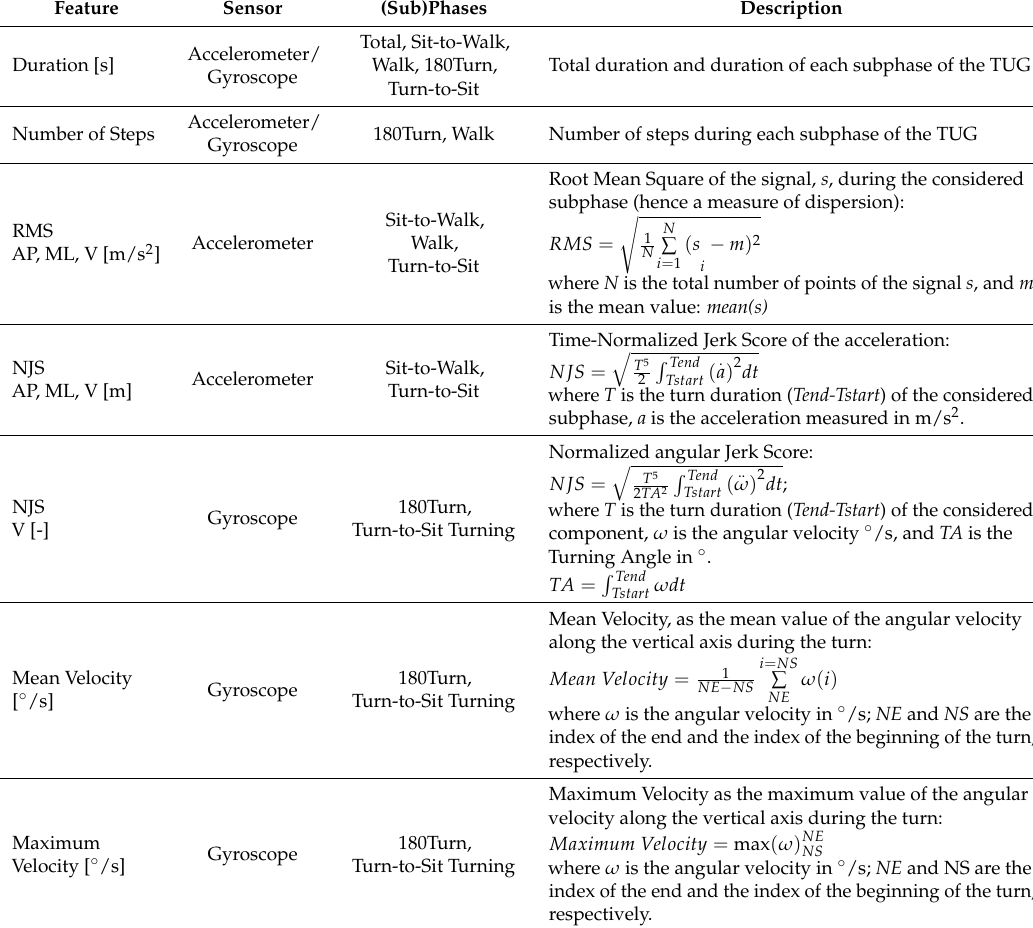
Table 2. Instrumented features extracted from the Timed Up and Go (TUG)